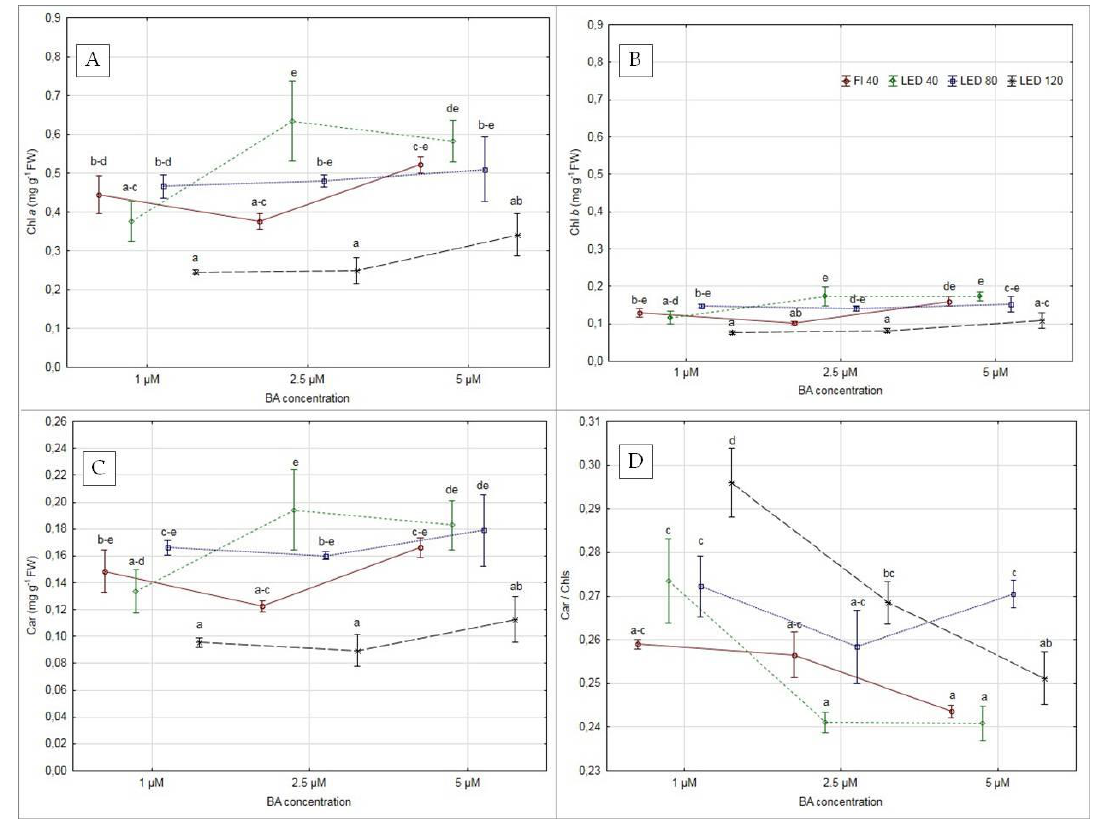
Figure 3. Photosynthetic pigment contents in Gerbera jamesonii leaves after six weeks of in vitro culture on Murashige and Skoog (MS) medium with various 6-benzyladenine (BA) concentrations and different photosynthetic photon flux densities (PPFDs). ( A ) Chlorophyll a content. ( B ) Chlorophyll b content. ( C ) Carotenoid contents. ( D ) The ratio of chlorophyll to carotenoid contents. Fl 40—control, fluorescent Philips TK-D 36W/54 lamps. LED 40, LED 80, LED 120 — combination of red (70%) and blue (30%) light emitted by light-emitting diodes with 40, 80, and 120 µmol m −2 s −1 PPFD, respectively. Error bars represent ± standard errors.